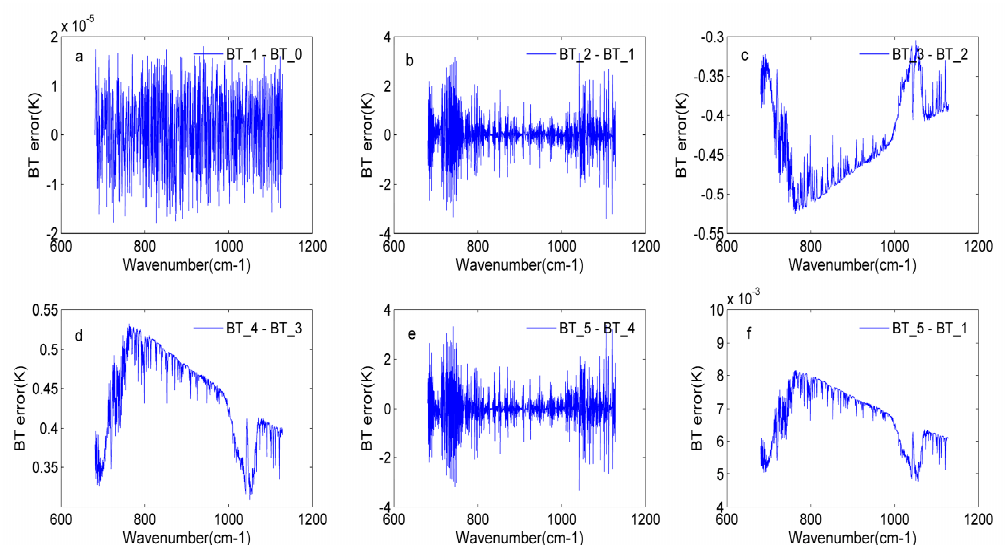
Figure 15. The BT error for detector 38 in the whole simulation process: ( a ) the BT error in the input BT (BT_0) and ideal BT (BT_1); ( b ) the BT error in the BT with off-axis effects (BT_2) and the ideal BT; ( c ) the BT error in the BT with off-axis effects and non-linearity response (BT_3) and BT_2; ( d ) the BT error in the BT after non-linearity correction (BT_4) and BT_3; ( e ) the BT error between BT after off-axis correction (BT_5) and BT_4; ( f ) the BT error in BT_5 and BT_1.